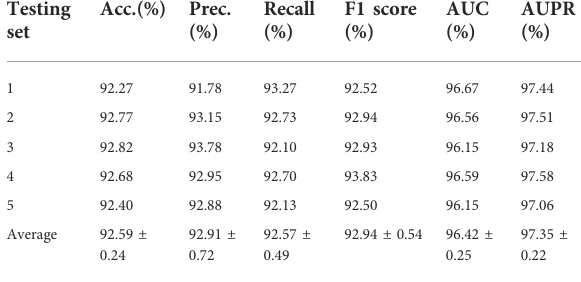
TABLE 2 Five-fold cross-validation results performed by MKFGCNII based on HMDD v.2.0. Testing Acc.(%) Prec. set (%)